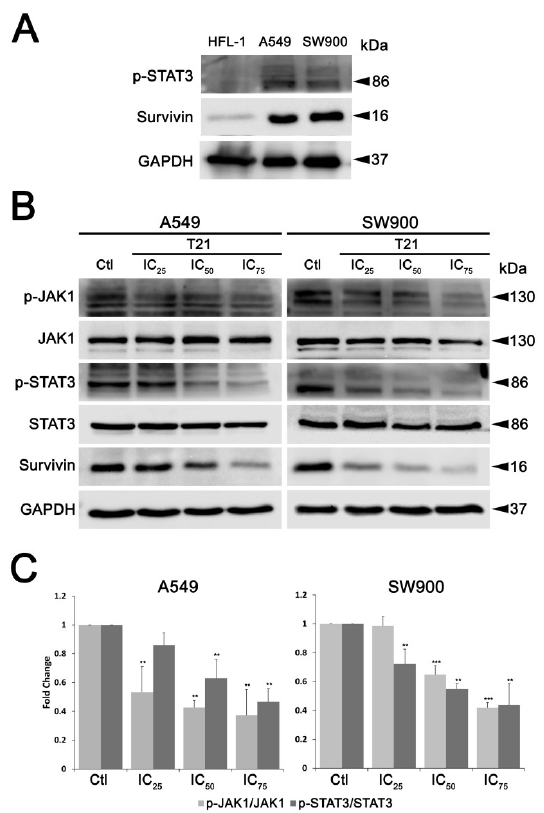
Figure 4. STAT3 pathway analysis. ( A ) STAT3 signaling in lung normal and cancer cells. Levels of phospho-STAT3 and survivin were analyzed by western blot in HFL-1, A549 and SW900 cells. ( B , C ) JAK / STAT3 pathway inactivation after T21 treatment. After 24 h of treatment with the IC 25 , IC 50 , IC 75 values of T21 (Table S1), the expression and phosphorylation levels of several members of JAK1 / STAT3 pathway were analyzed by Western blot in A549 and SW900 cells. Results were obtained from at least three independent experiments. Bars represent the mean ± SD. Statistically significant results are indicated as *, p -value < 0.05; **, p -value < 0.01 and ***, p -value <